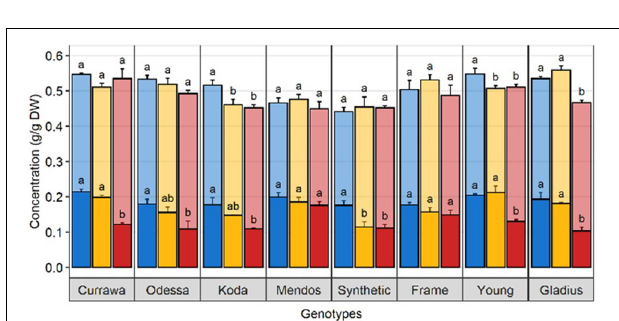
FIGURE 6 | Drought and combined drought and heat stress altered WSC and starch balance in grains at 12 DAA. Water-soluble carbohydrates (solid) and starch (transparent) concentration in grains at 12 DAA from plants grown under well-watered conditions (blue), drought (orange), or combined drought and heat stress (red). The sum of WSC and starch concentrations constitutes the non-structural carbohydrate (NSC). Values are means of three replicates ( ± SE). Letters (top: NSC, bottom: WSC) indicate the results of Tukey’s test comparing treatment effects within each genotype ( p <